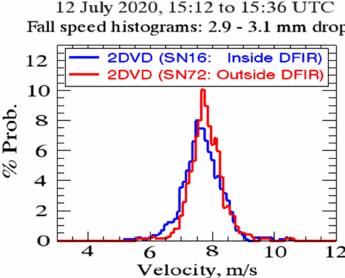
Figure 2. Histograms of fall speeds from 2D-video inside the DFIR and the one sited outside.